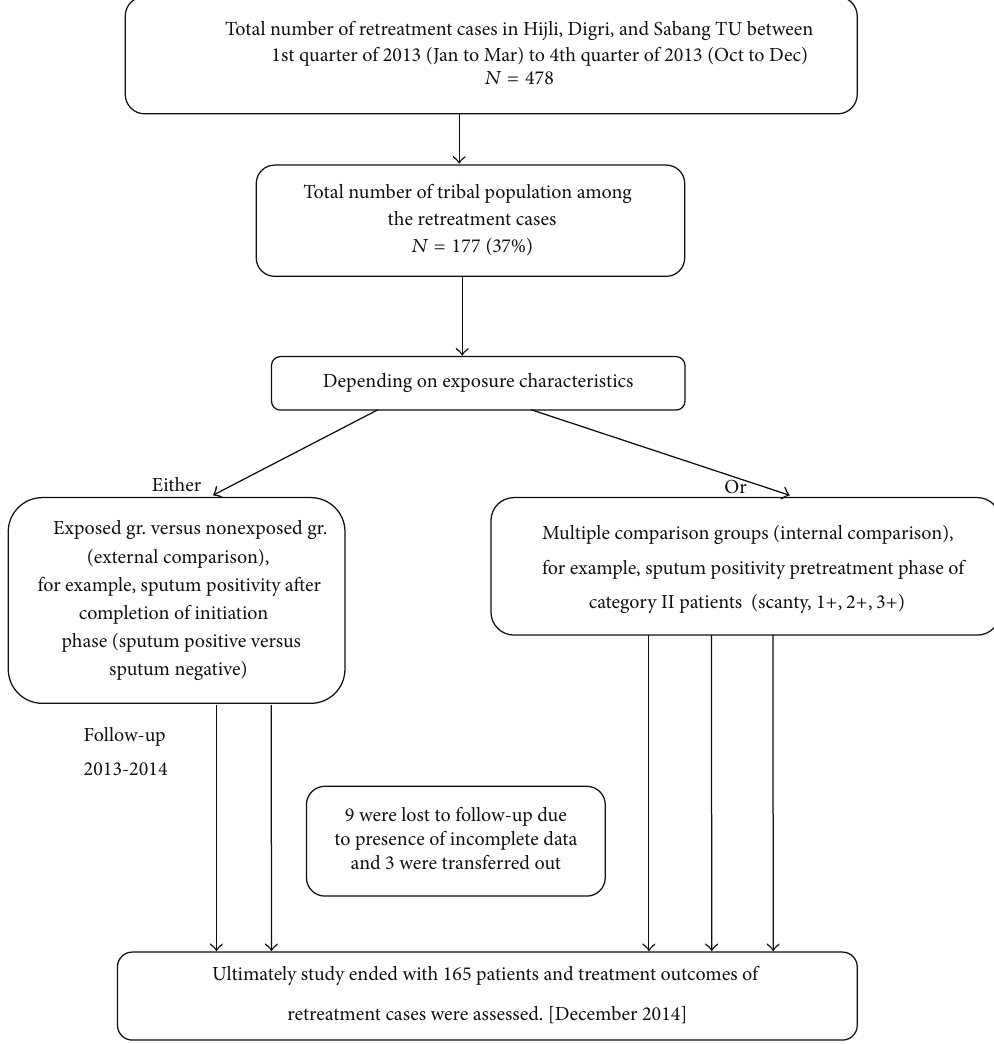
Figure 1: Schematic diagram showing the study